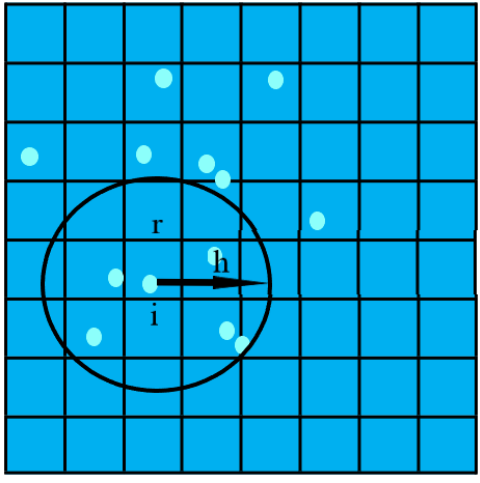
Figure 5. Schematic diagram of particle search based on